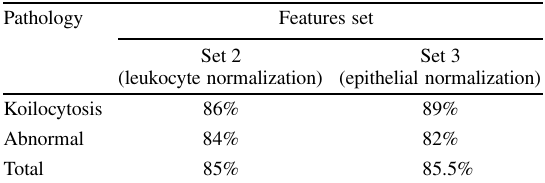
Percentage of correct classification of koilocytosis and abnormal specimen using given by stepwise discriminant analysis using fea- tures set 2 and 3. F -to-enter: